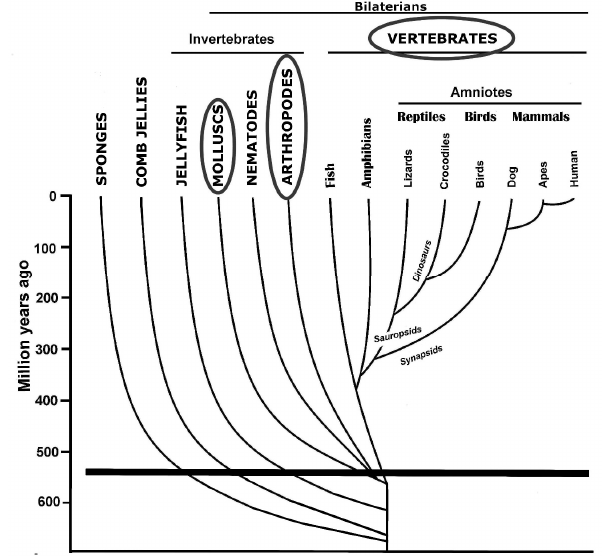
Figure 2. Phylogenetic tree depicting key animal lineages. Names in capital letters are phyla (trivial names are used), and the three most successful are circled. Only a few of the forty or so phyla present today are included. The thick, horizontal line indicates the ‘Cambrian explosion’, a time with a massive diversification of bilateral animals.